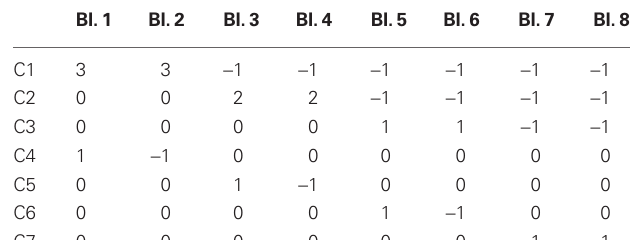
Table 1 | Orthogonal Contrasts used to describe differences between